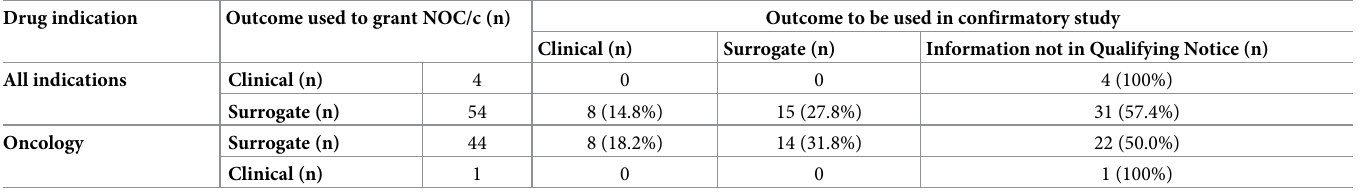
Table 3. Outcome used to grant Notice of Compliance with conditions (NOC/c) and outcome to be used in confirmatory studies. Drug